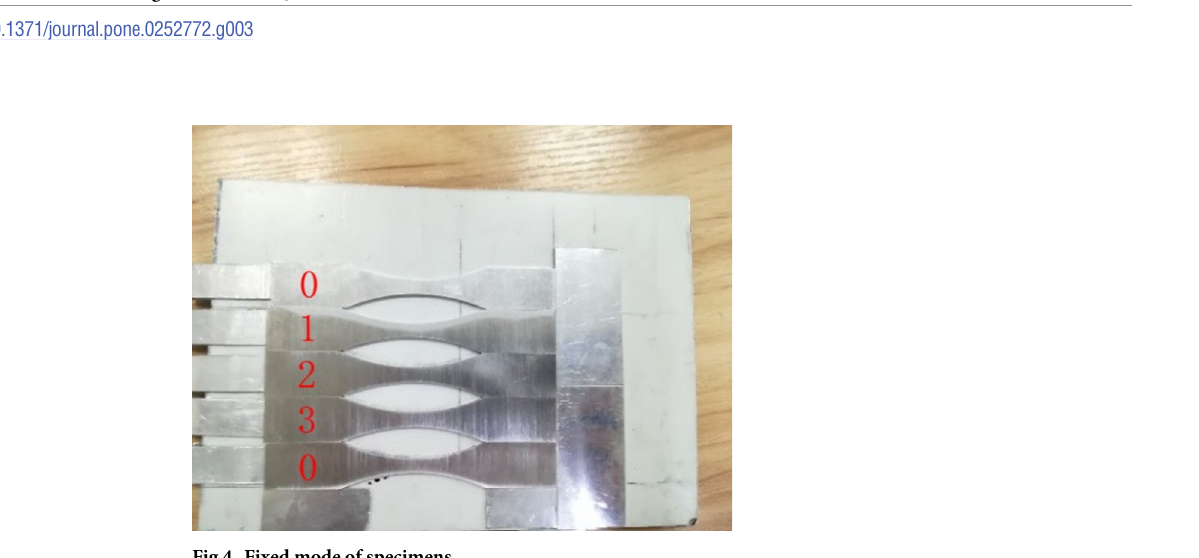
Fig 4. Fixed mode of specimens.